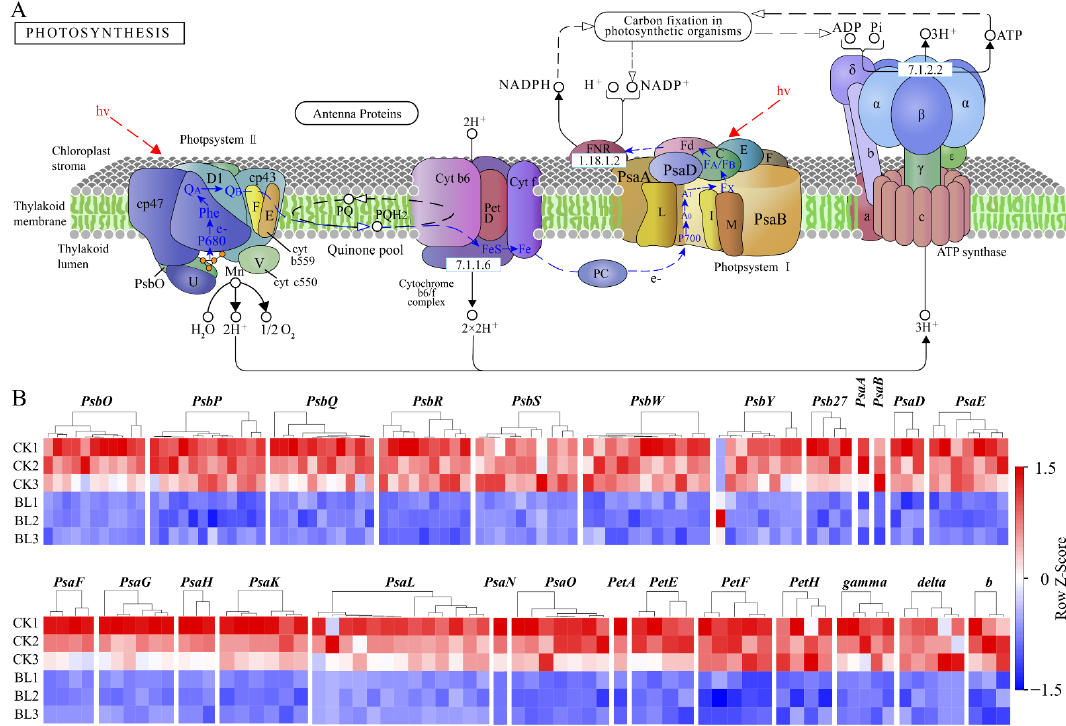
Figure 6. Almost all of the DEGs in the photosynthesis pathway were downregulated in the BL treatment. ( A ) Photosynthesis pathway (https://www.kegg.jp/entry/map00195 (accessed on 24 April 2022)). ( B ) Expression heat maps of the DEGs in 26 subunits—8 subunits (PsbO, PsbP, PsbQ, PsbR, PsbS, PsbW, PsbY, Psb27) in the “PSII complex”, 11 subunits (PsaA, PsaB, PsaD, PsaE, PsaF, PsaG, PsaH, PsaK, PsaL, PsaN, PsaO) in the “PSI complex”, 1 subunit (PetA) in the “cytochrome b6/f com- plex”, 3 subunits (PetE, PetF, PetH) in the “photosynthetic electron transfer chain”, and 3 subunits ( γ , delta, b) in “f-type ATPase” in the six samples, respectively.